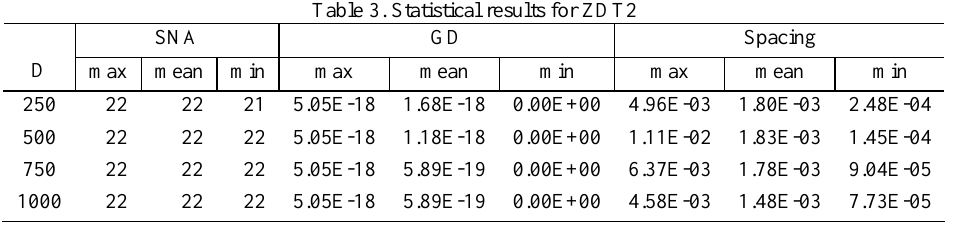
Table 3. Statistical results for ZDT2